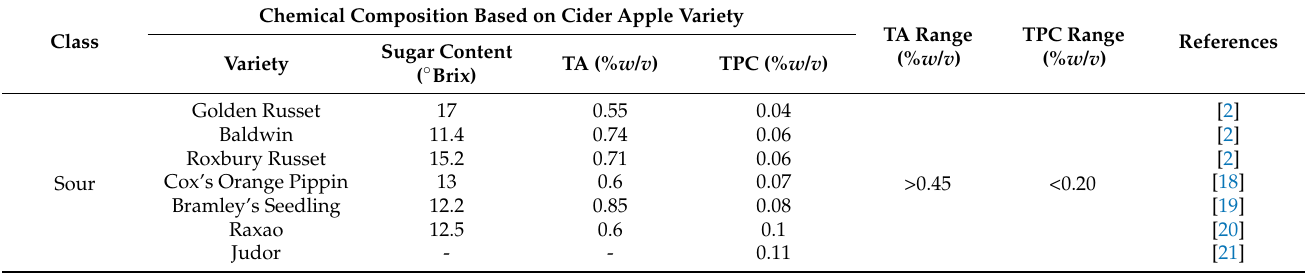
Table 1. Classification of cider apples in terms of sugar content ( ◦ Brix), titratable acidity (TA) and total phenolic content (TPC), with typical